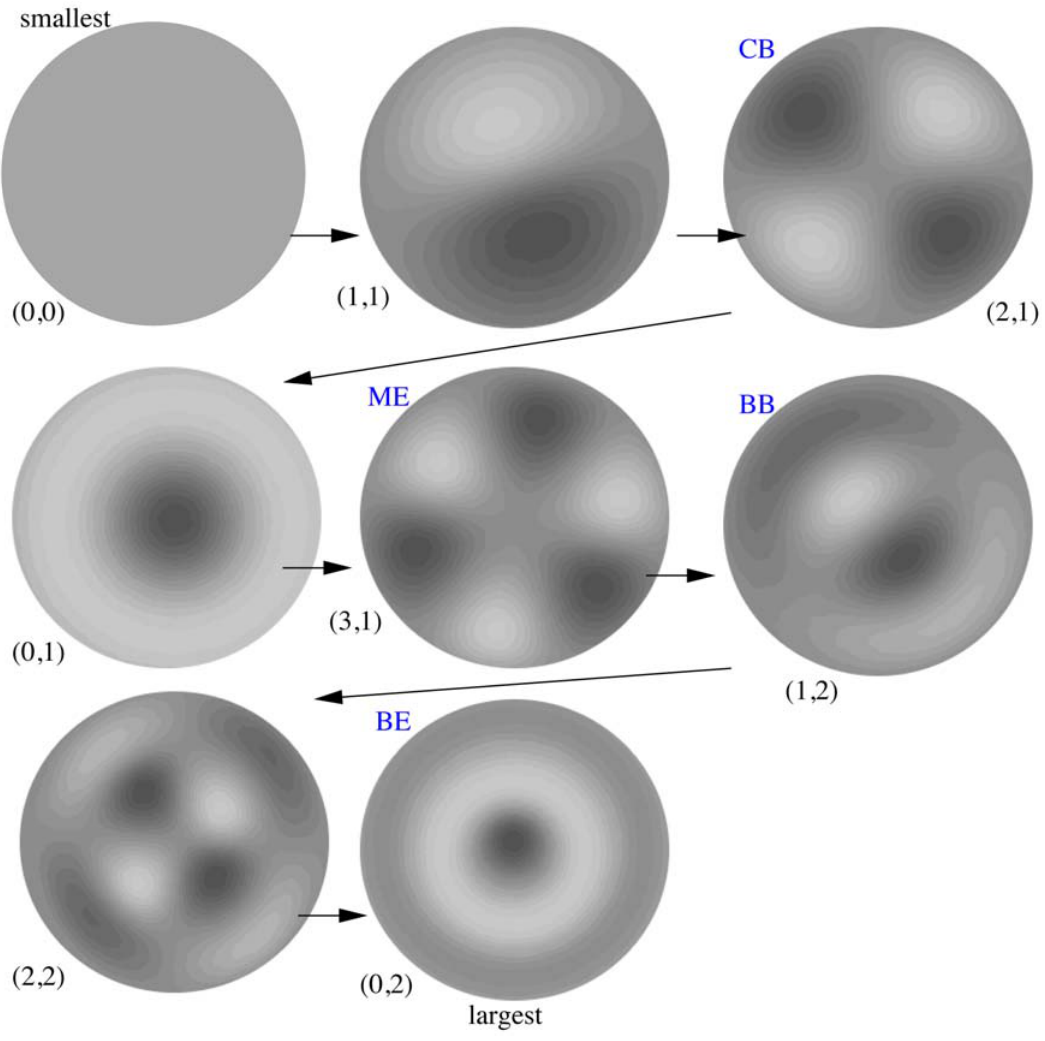
Figure 4. Sequence of possible patterns assuming no-flux boundary conditions and size of the barrel as a parameter. Dark regions correspond to highest density of thalamocortical axons. White areas correspond to density less than background. Blue labels are the named patterns seen in the data. All barrels are drawn at the same diameter. Numbers in parentheses, ( m , l ) , denote the order of the Bessel function, m , and its zero, l ; see figure